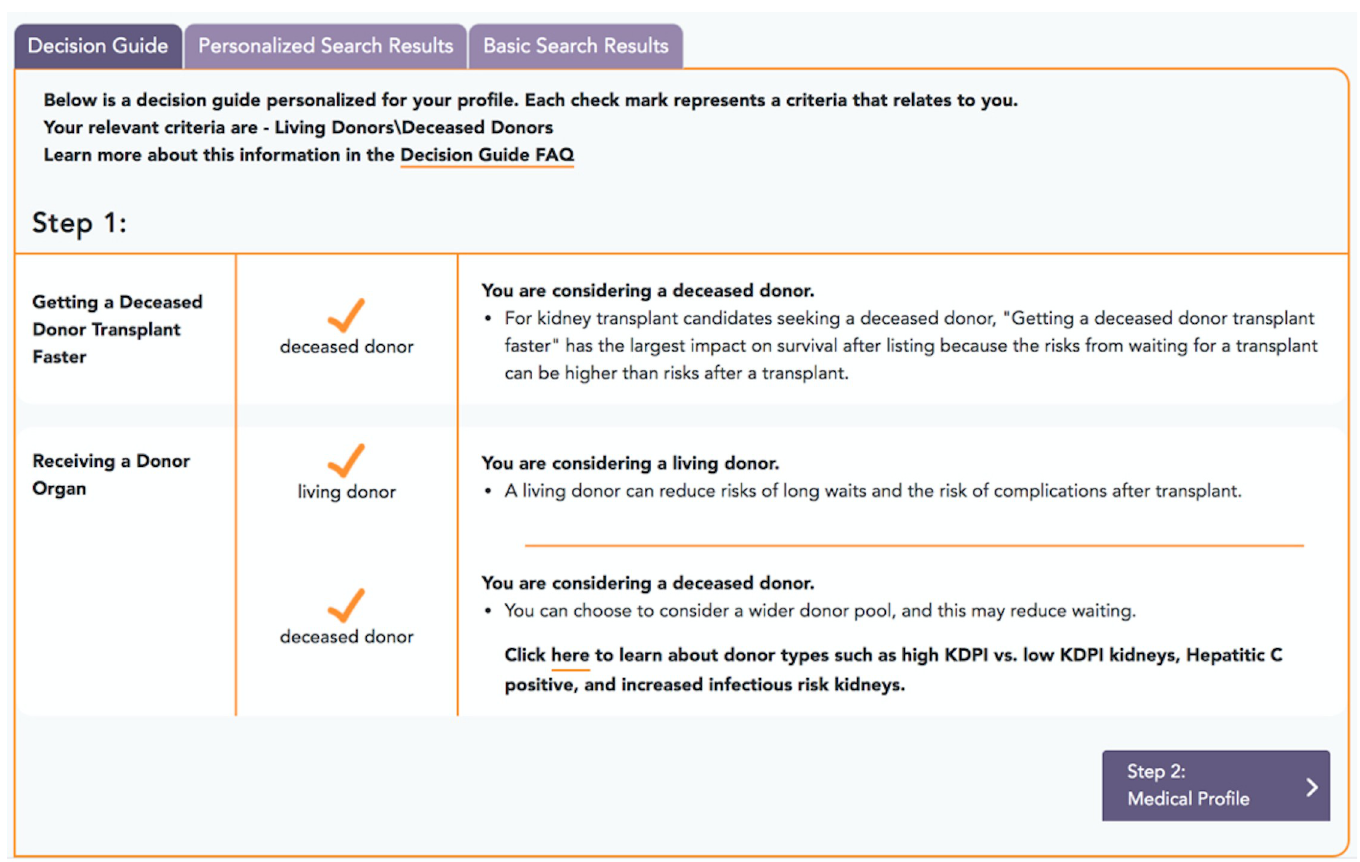
Fig 4. Development website screenshot of a decision guide to provide context about the transplant process for different donor types. The guide was added as a resource for users who may not have characteristics that would lead to being declined for a